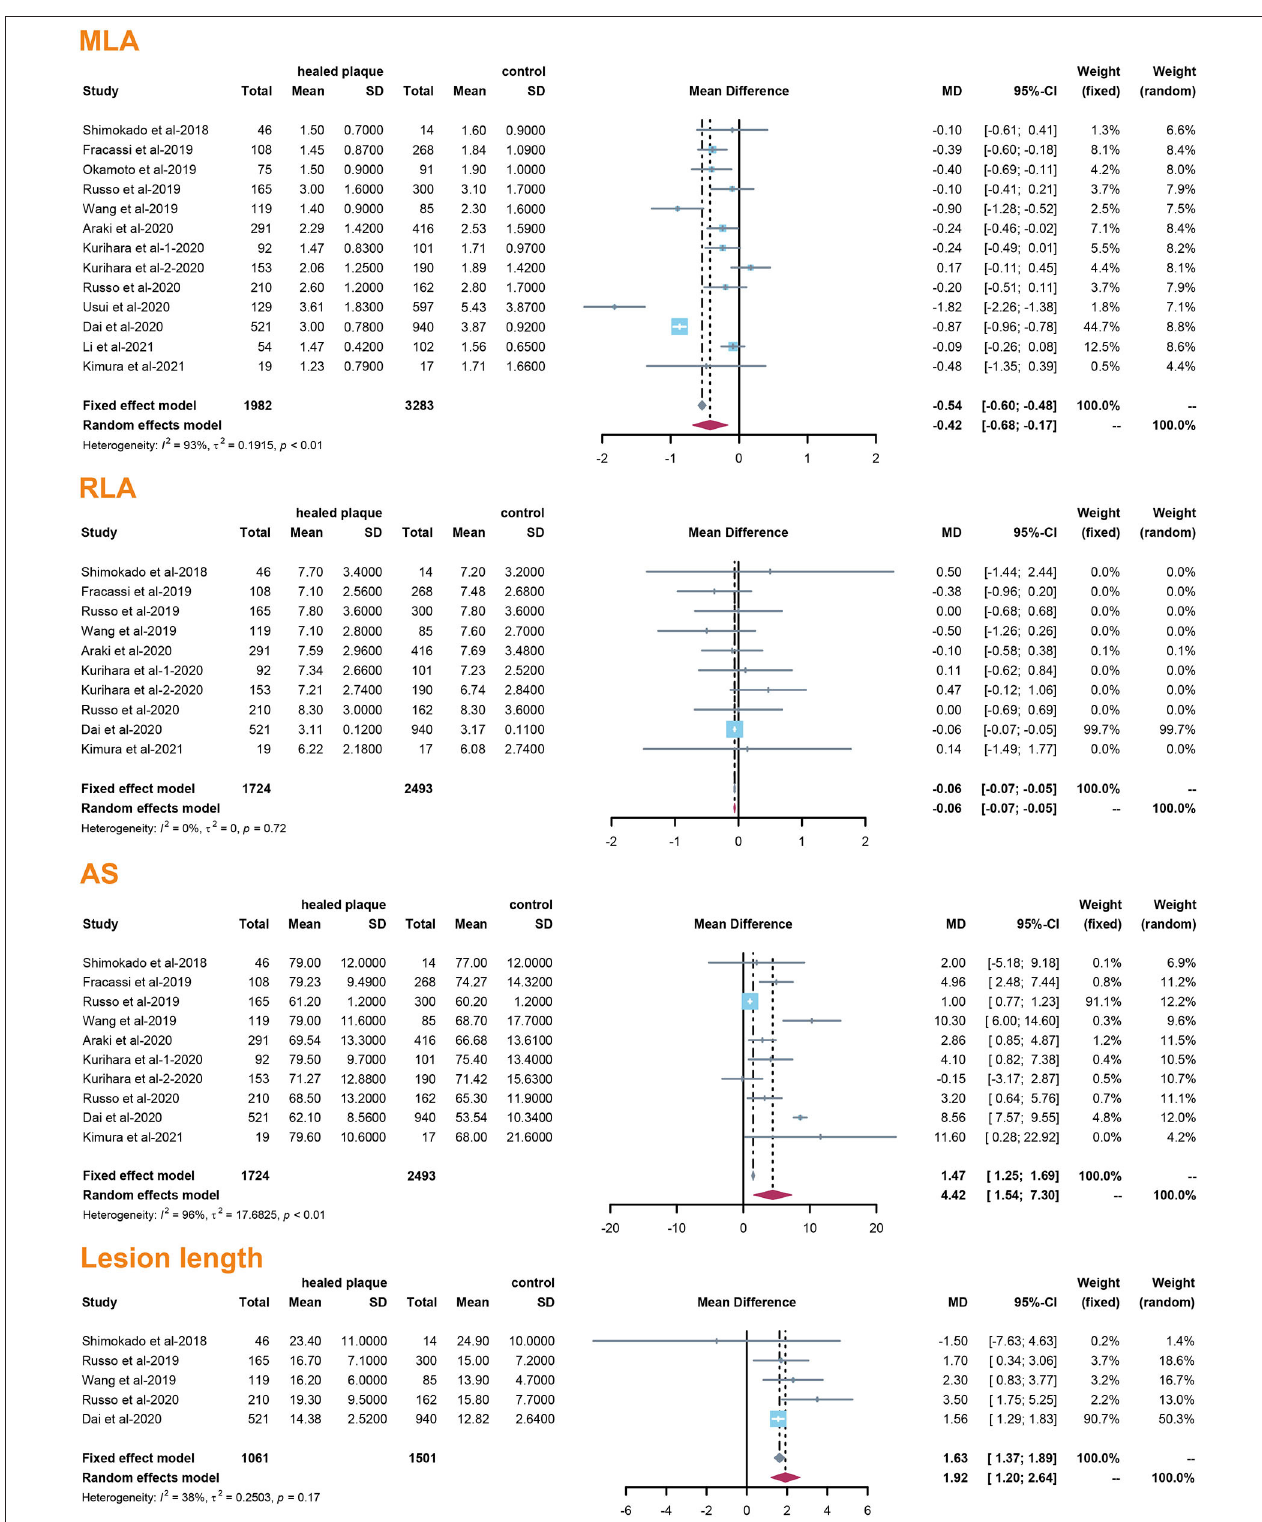
FIGURE 3 | Summary of quantitative characteristics of healed plaques in the total population. MLA, minimal lumen area; RLA, reference lumen area; AS, area stenosis.